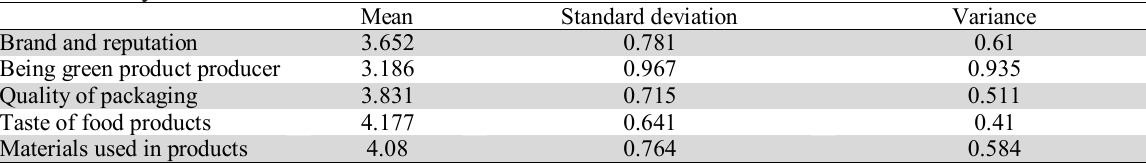
Fig. 1. Personal characteristics of the participants in terms of percentage The summary of some basic statistics Mean Standard deviation